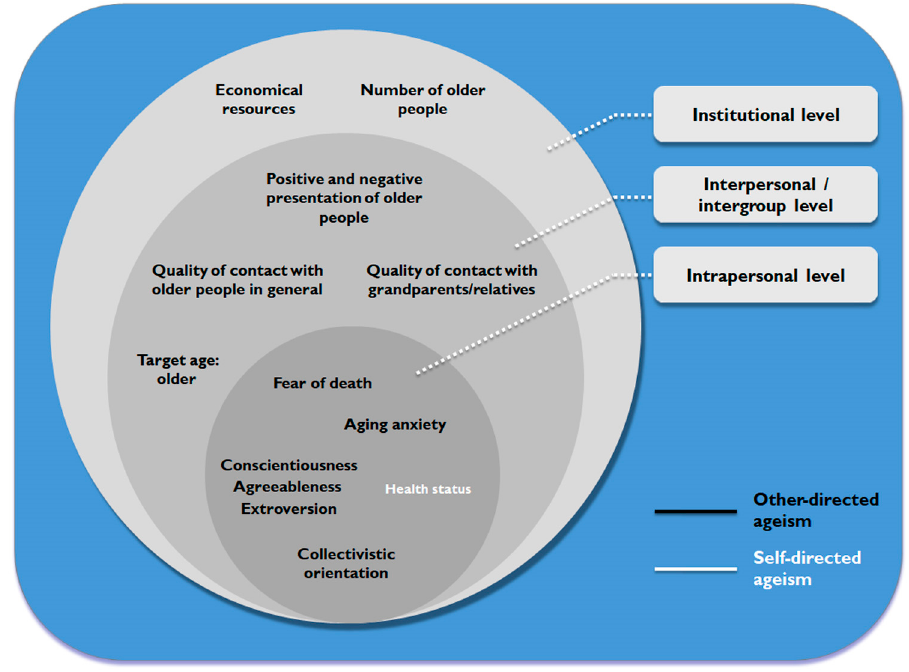
Figure 3. Determinants of ageism across intrapersonal, interpersonal/intergroup and institutional levels.